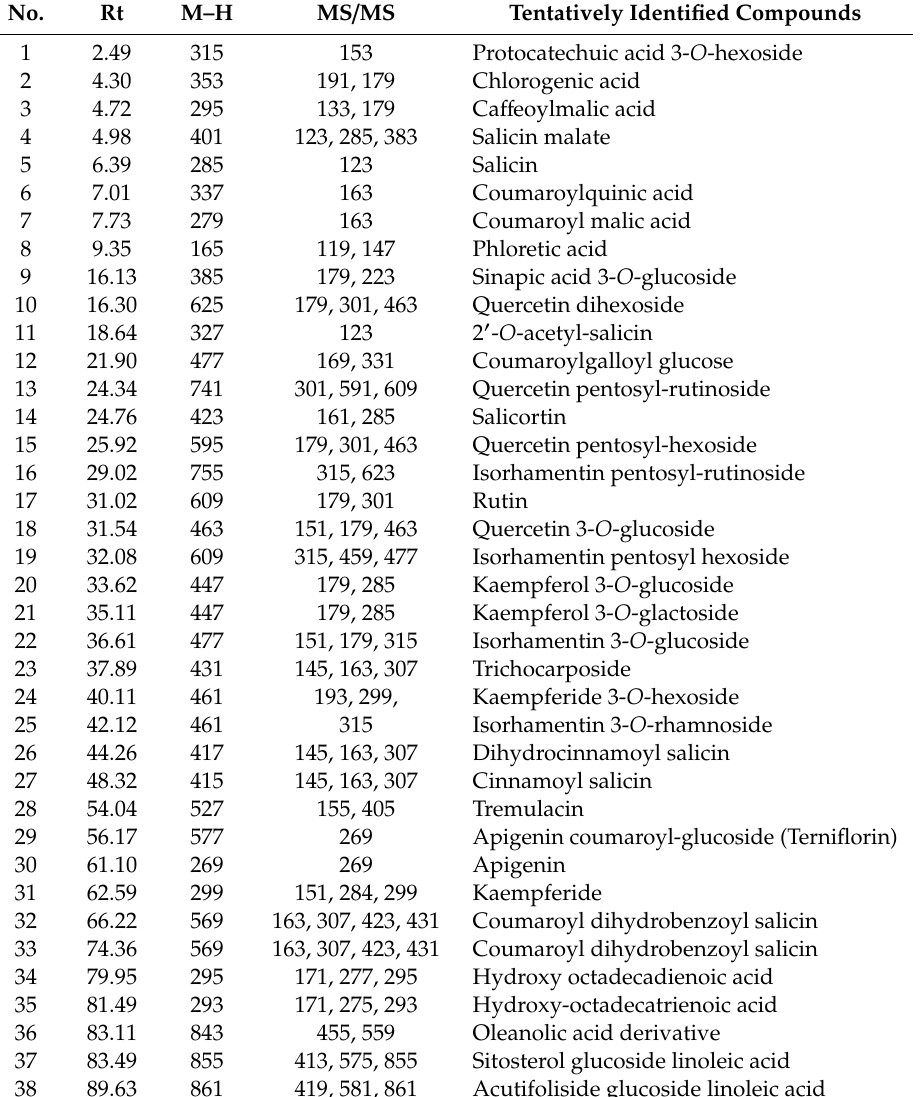
Table 1. Secondary metabolites from Salix tetrasperma flower